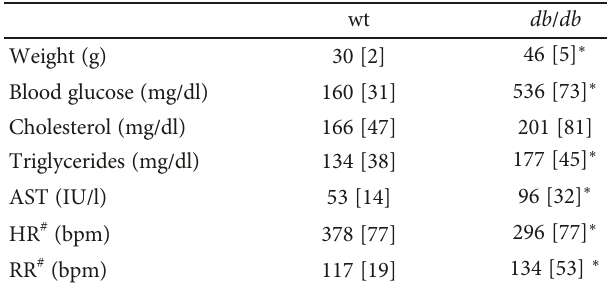
Table 2: Ultrasonographic cardiac parameters in the two groups of